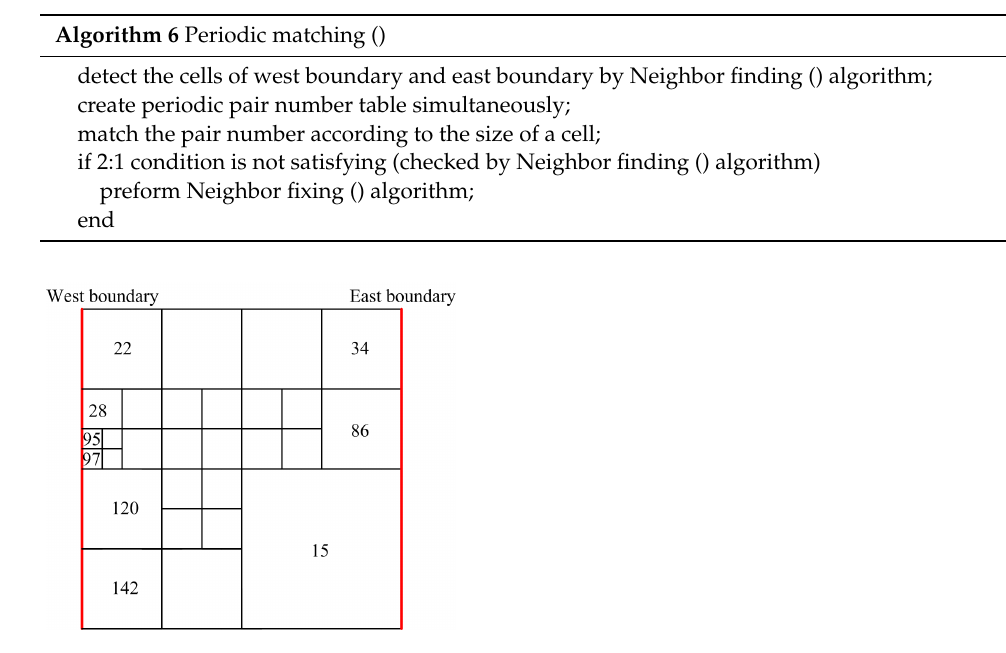
Figure 6. An example of periodic boundary condition. Table 2. Periodic pair number table.